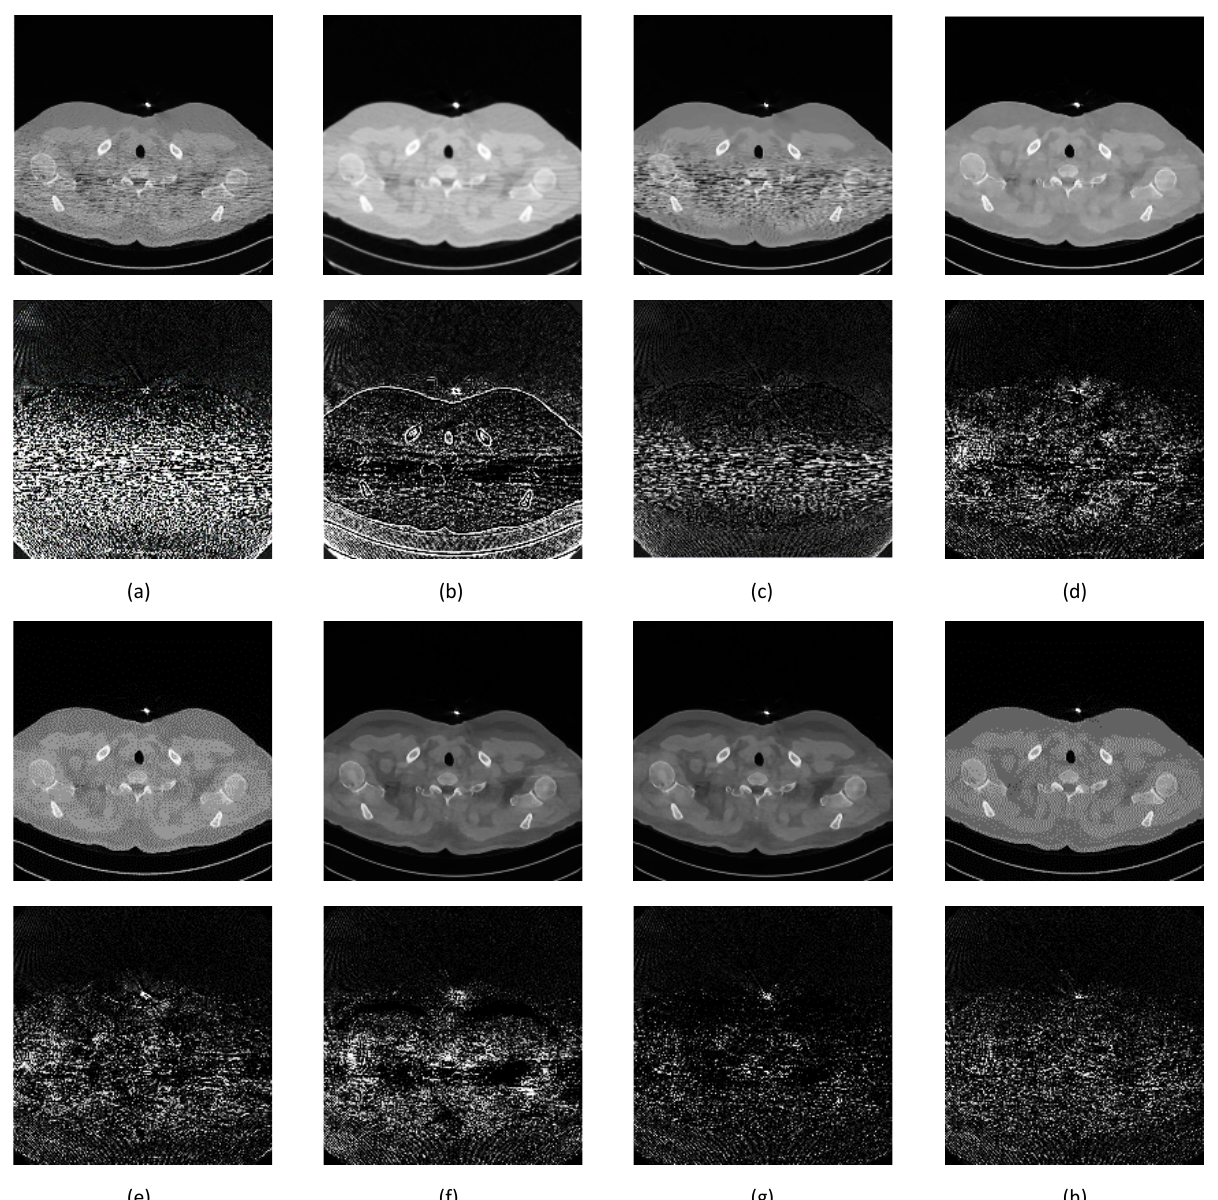
Figure 12. Image comparison between denoising methods on the upper thorax. The first row is the denoising result while the second row is the noise mask. ( a ) NLM, 51.3995 dB; ( b ) Gaussian, 57.4996 dB; ( c ) BM3D, 53.7341 dB; ( d ) SegNet, 61.4247 dB; ( e ) DeConvNet, 61.4975 dB; ( f ) RedNet, 61.1857 dB; ( g ) U-Net, 61.6218 dB; and ( h ) S-Dual 3, 62.3070 dB. Two additional image set (Figures 13 and 14) were added to confirm better improve- ment resulting from the proposed